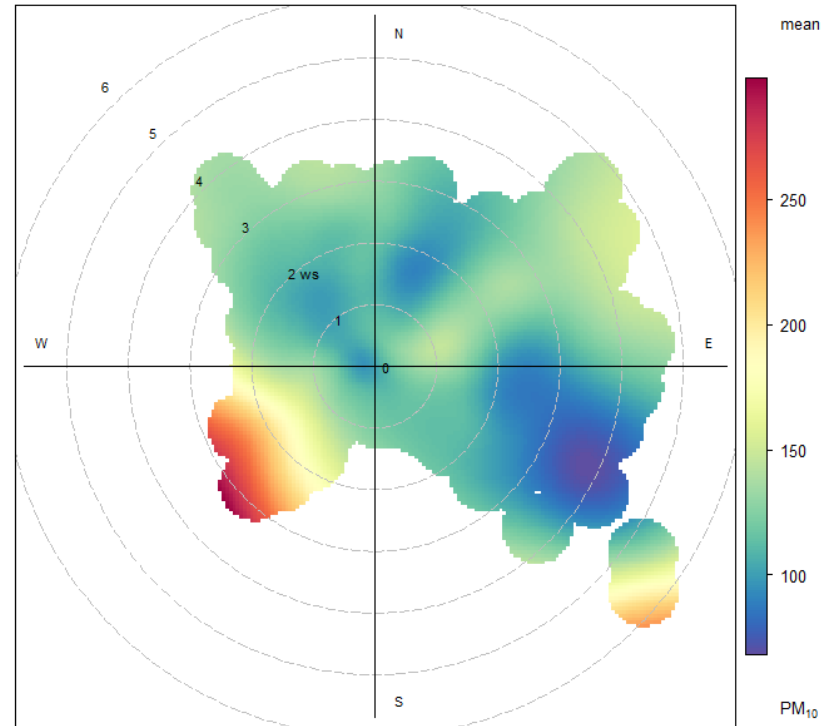
Figure 4. Histogram of wind speed ( upper panel), polar frequency plot ( middle panel), and polar plot ( lower panel) of wind speed and wind direction and PM 10 , using data from Aziziyah monitoring sites for 2020.